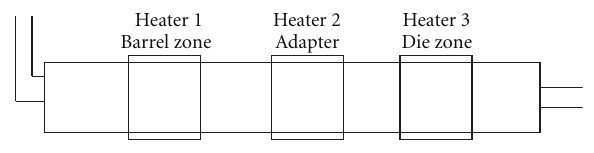
Figure 2: Temperature section of PVC